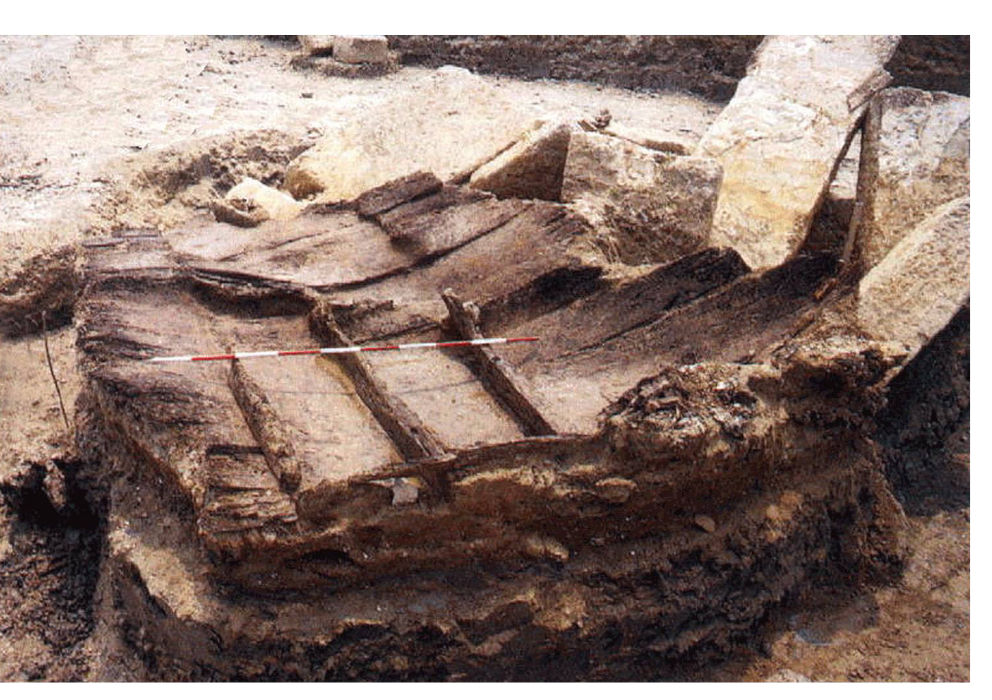
Figure 2: The port of Aquae in Kusjak (private documentation of Vladimir